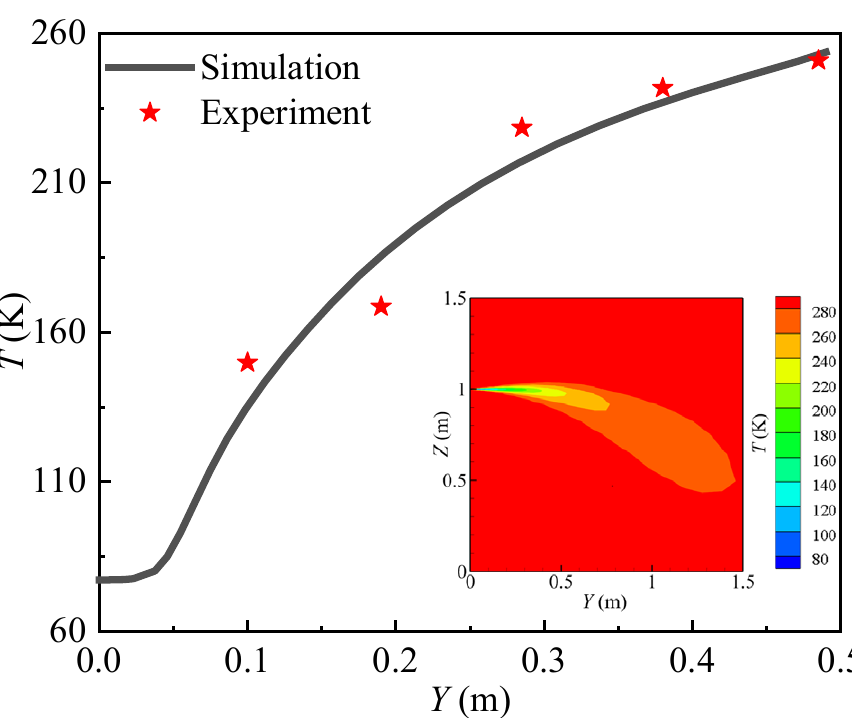
Figure 4. Numerical vs. experimental temperature variation.